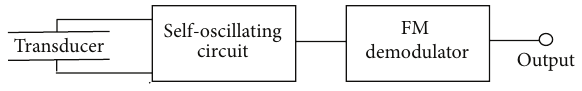
Figure 3: Diagram of the